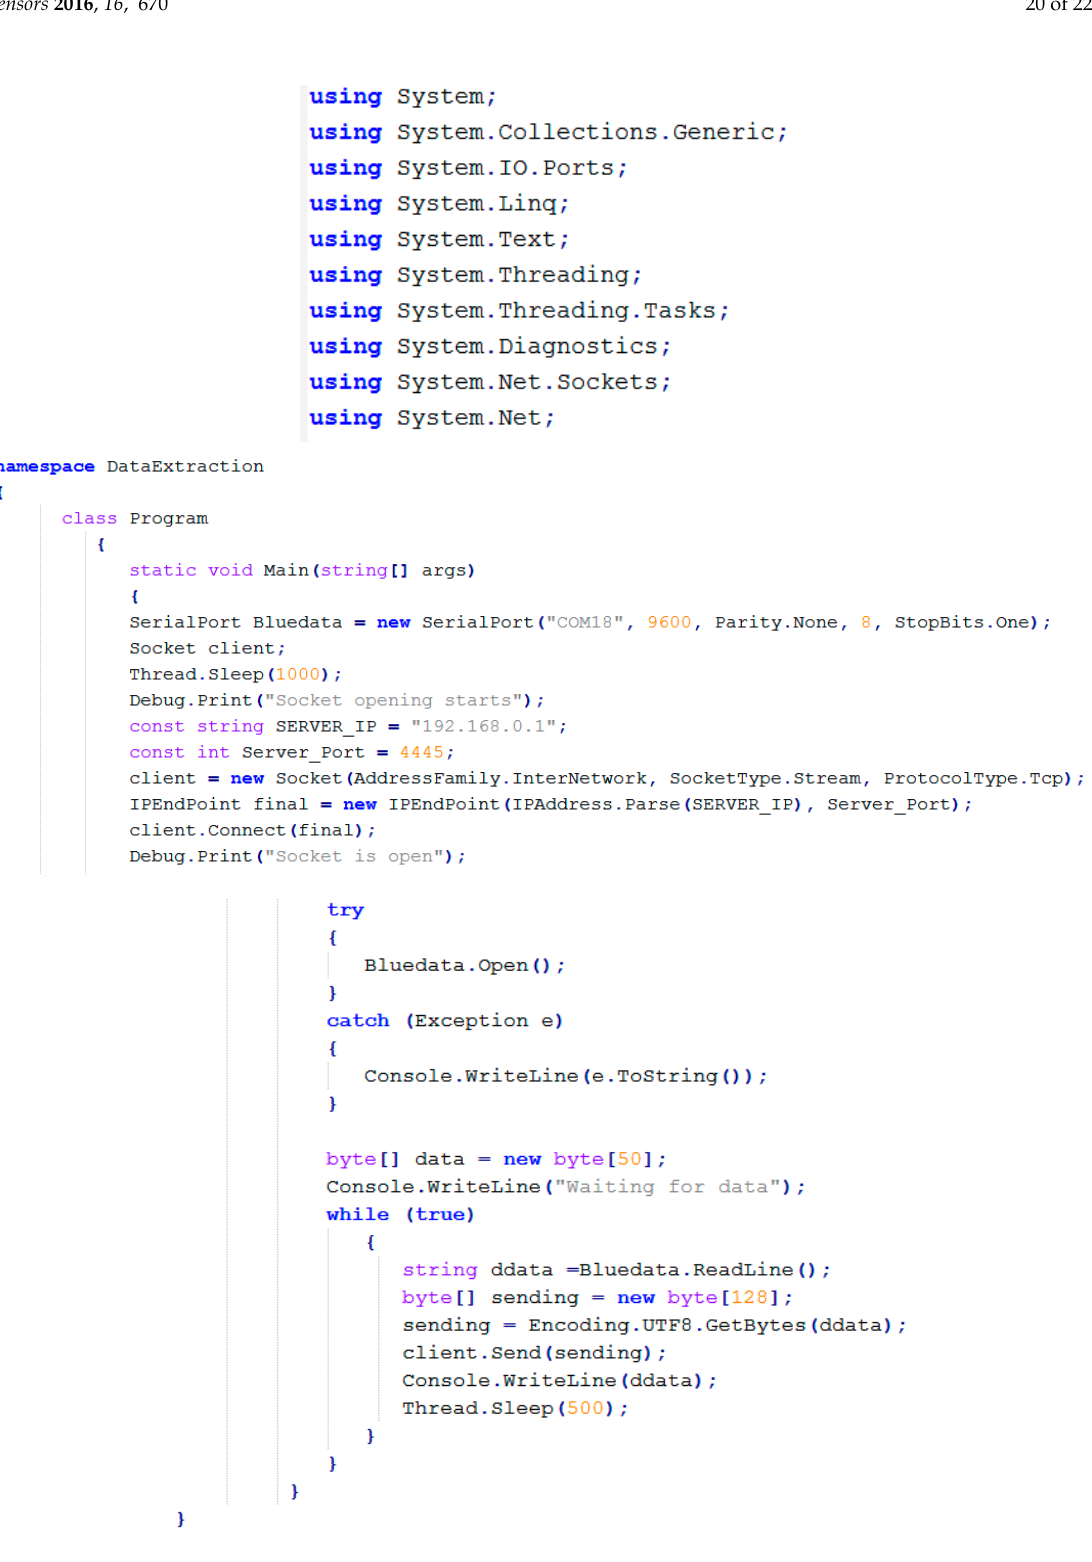
Figure A2. Generated instance in C# for smart sensor controller of BAN.